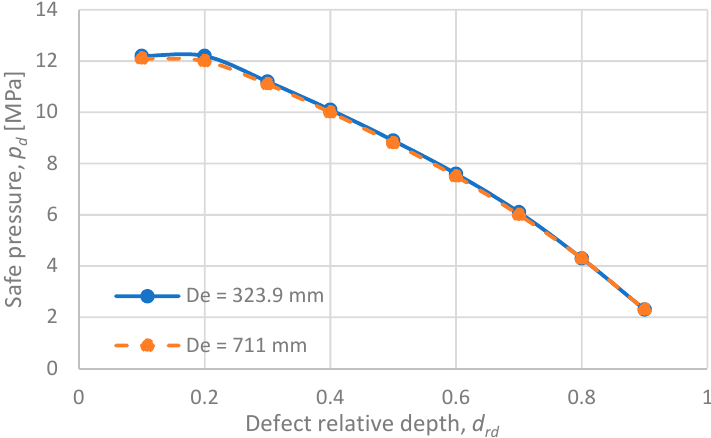
Figure 4. Safe operating pressure, p d , versus relative depth of the defect, d rd ; steel grade: X42.